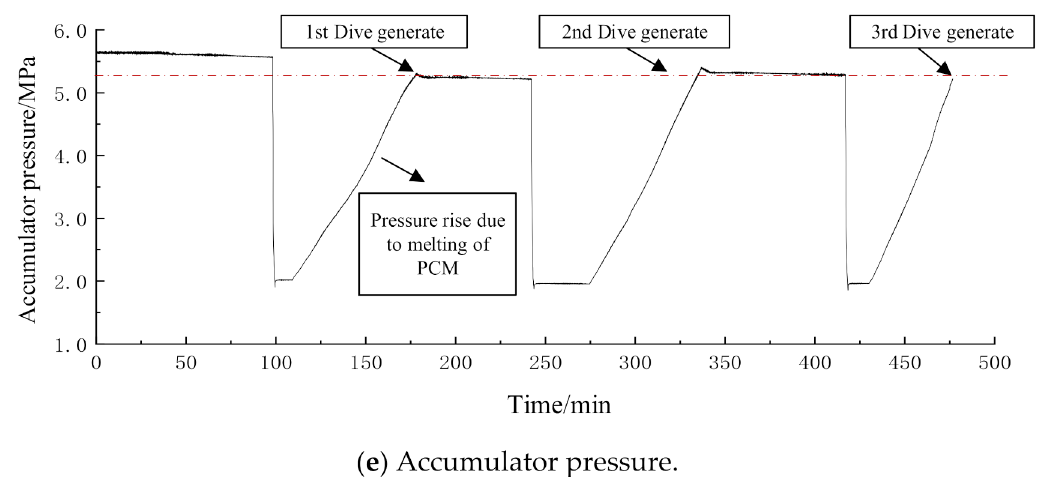
Figure 8. Profile State